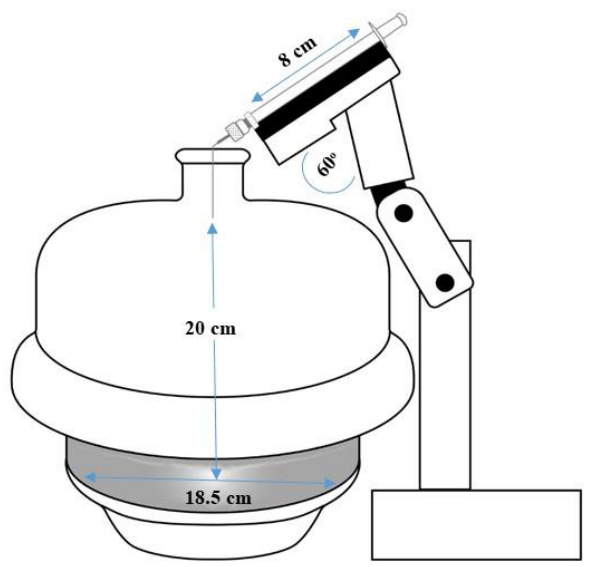
Figure 1. Schematic representation of the deposition system.